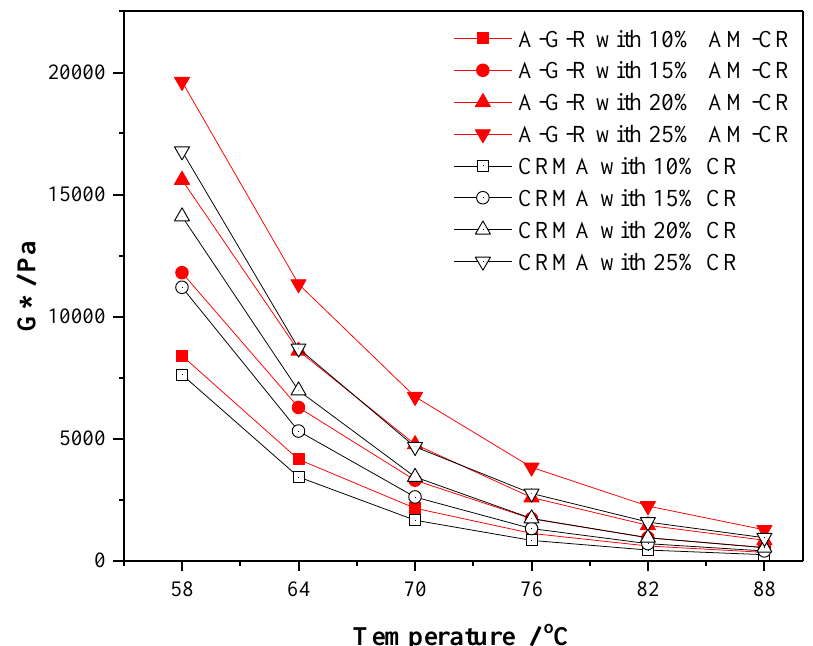
Figure 6. The complex modulus ( G *) of CRMA and A–G–R.